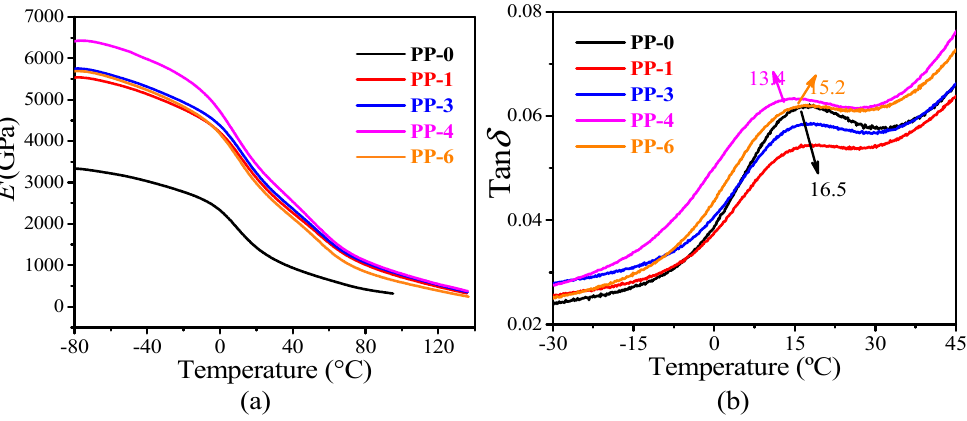
Figure 7. ( a ) Storage modulus and ( b ) glass transition temperature of PP composites